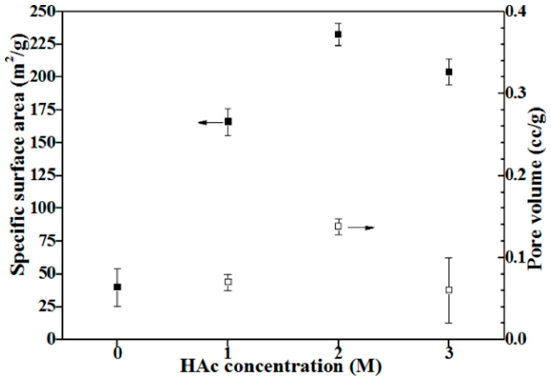
Figure 6. Specific surface areas and pore volumes of untreated and HAc-treated BG powders.